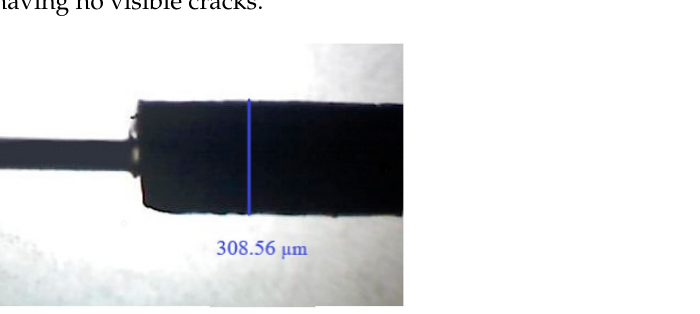
Figure 1. Image of the produced SPME fiber (on the left side, a glass core can be seen) magnified by 50 × , and respective diameter.